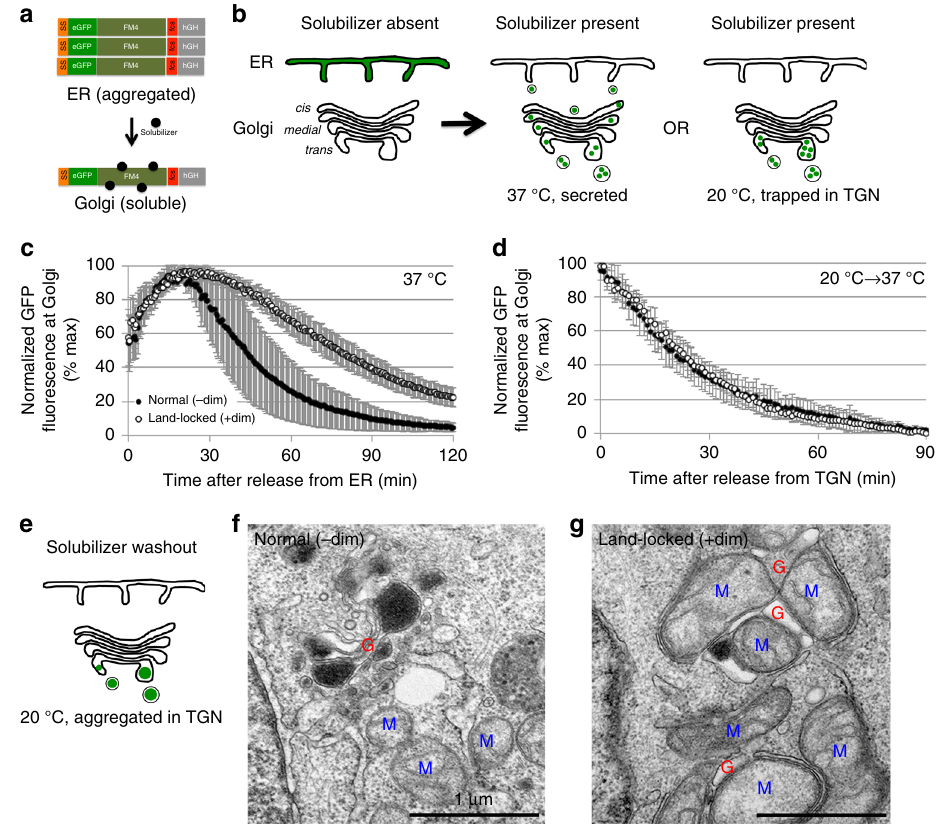
Fig. 4 Live imaging a wave of anterograde cargo through individual normal or land-locked Golgi areas. a Cartoon schematic of the anterograde cargo ss-GFP-FM4-FCS-hGH. This cargo is aggregated and trapped in the ER until solubilizer is added. Then, the monomeric cargo is released from the ER for secretion. b Cartoon of ss-GFP-FM4-FCS-hGH cargo traf fi c and effect of temperature block. A wave of anterograde traf fi c is initiated from the ER by the addition of solubilizer at 37 °C, and the cargo is secreted out of the Golgi. However, at 20 °C, traf fi c is slowed so that the cargo accumulates at the TGN instead of getting secreted. c Quanti fi cation of a wave of cargo released at 37 °C from normal ( n = 9) or land-locked ( n = 9) Golgi in HT1080 cells that stably express ss-GFP-FM4-FCS-hGH (refer to Supplementary Fig. 6a, b for representative images and Table 2 for numbers). d Quanti fi cation of a wave of cargo after release from 20 °C block from normal ( n = 9) or land-locked ( n = 6) Golgi in HT1080 cells that stably express ss-GFP-FM4-FCS-hGH (refer to Supplementary Fig. 6c, d for representative images and Table 2 for numbers). The Golgi exit rate is almost indistinguishable between normal and land-locked Golgi. e Cartoon of the effect of 20 °C block combined with solubilizer washout on ss-GFP-FM4-FCS-hGH, which re-aggregates the cargo in the TGN. f , g TEM images of re-aggregated ss-GFP-FM4-FCS-hGH cargo in HT1080 cells that stably express ss-GFP-FM4-FCS-hGH. Large aggregated cargo can be seen in the lumen of f normal, stacked cisternae and g land-locked cisternae. Scale bar is 1 μ m. Error bars =